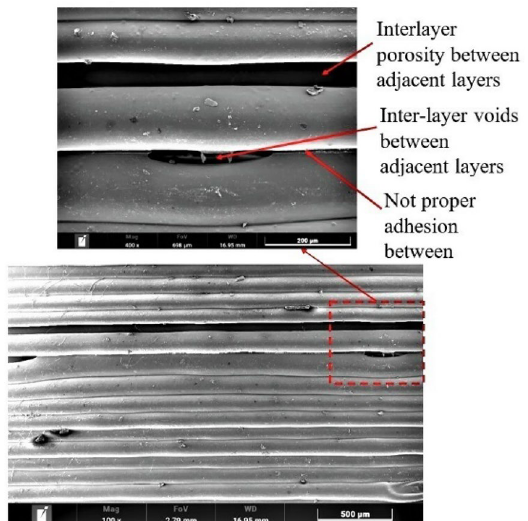
Figure 5 SEM micrograph of specimen obtained from Experiment 4